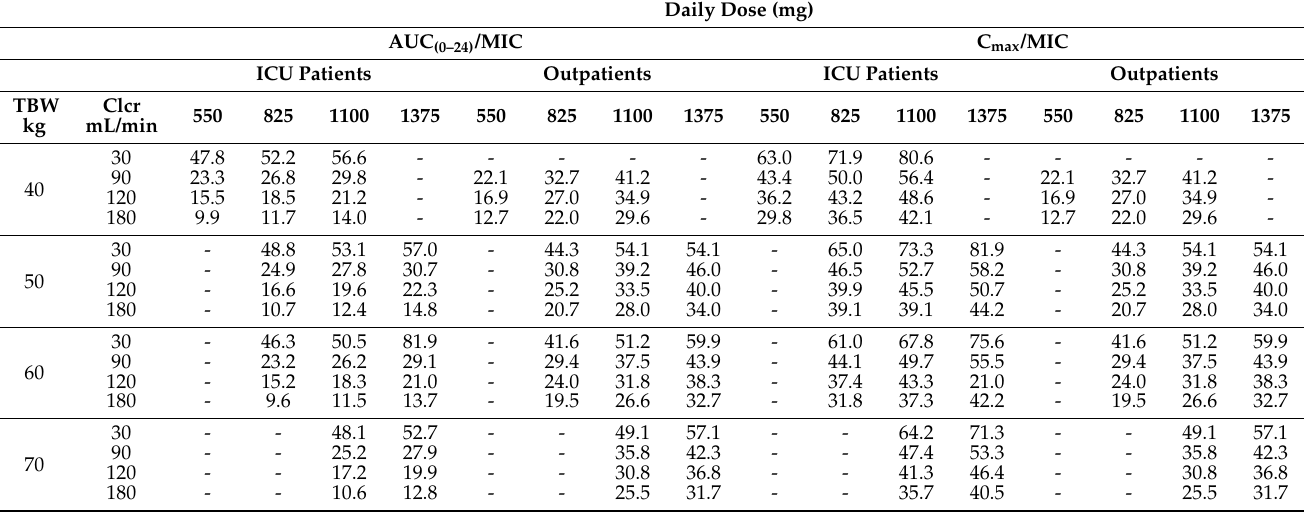
Table 4. Fractional target attainment for ethambutol in ICU and outpatients according FDC dosing recommendations against the EUCAST MIC distribution for Mycobacterium tuberculosis-7H9 (MIC distribution 0.25 to 32